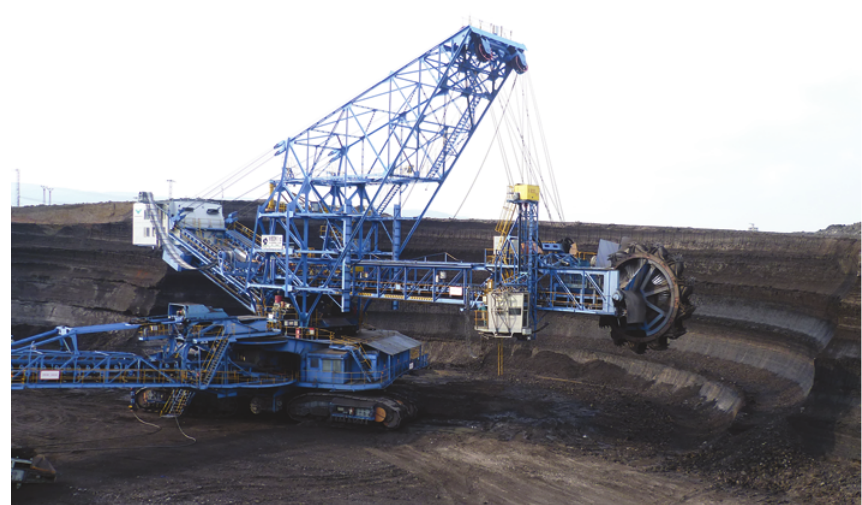
Fig. 1. Bucket-wheel excavator K800/N1/103